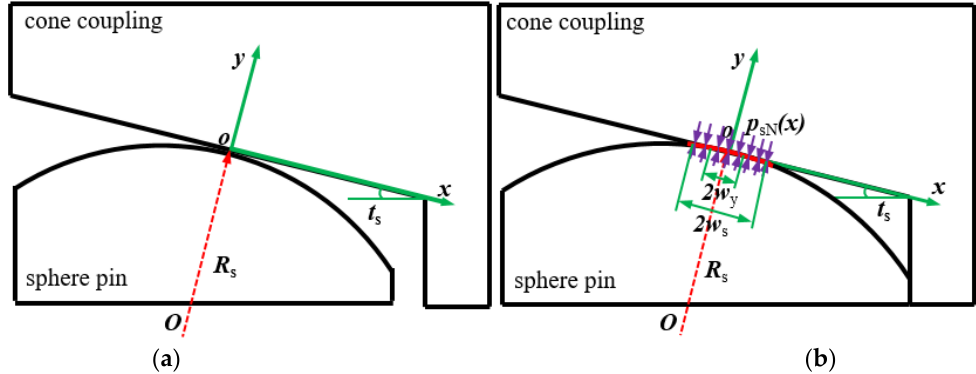
Figure 3. Schematic of sealing formation process for a sphere-to-cone contact premium connection, initial sealing contact is for ( a ) and final sealing contact is for ( b ).